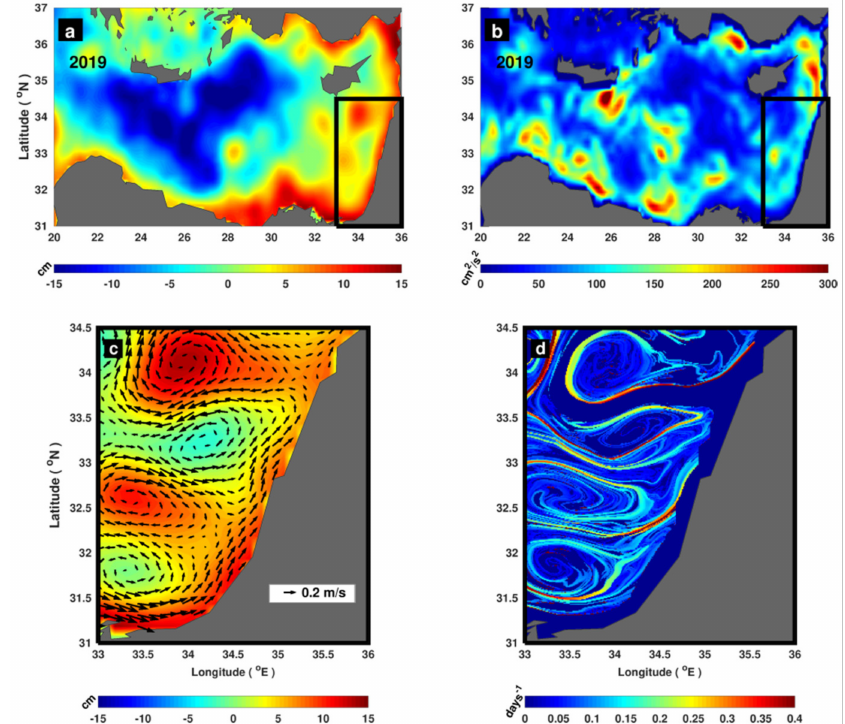
Figure 3. The region of the oil spill accident in the Mediterranean Sea. Panels ( a , b ) represent 2019 mean sea surface height (in cm) and the mean eddy kinetic energy (in cm 2 /s 2 ), respectively, in the Eastern Mediterranean basin. The black rectangle shows the region affected by the East Mediterranean oil spill, which is reported in panels ( c , d ). The sea surface height (color, in cm) and the derived current velocities (arrows, in m/s) in the smaller scaled region of the East Mediterranean oil spill on the 2nd of July 2019 are mapped in panel ( c ). The altimetry-derived finite-size Lyapunov exponent (in days − 1 ) for the same date is computed backward in time ( d